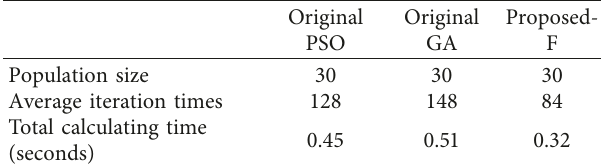
Total calculating time (seconds) Table 3: Comparison of computational complexity of original GA, PSO, and the proposed fusion technique for SML estimation for the noncoherent case.